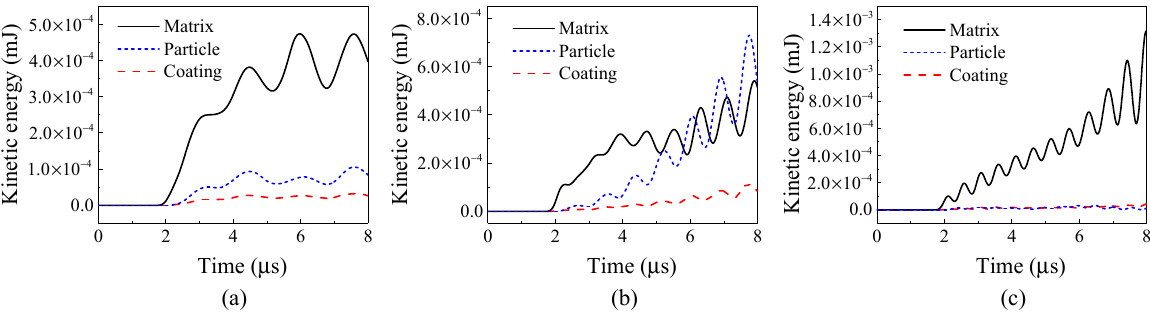
Figure 8. Kinetic energies of matrix, particles and coating with ( a ) f = 0.3 MHz, ( b ) f = 0.6 MHz, and ( c ) f = 0.9 MHz.